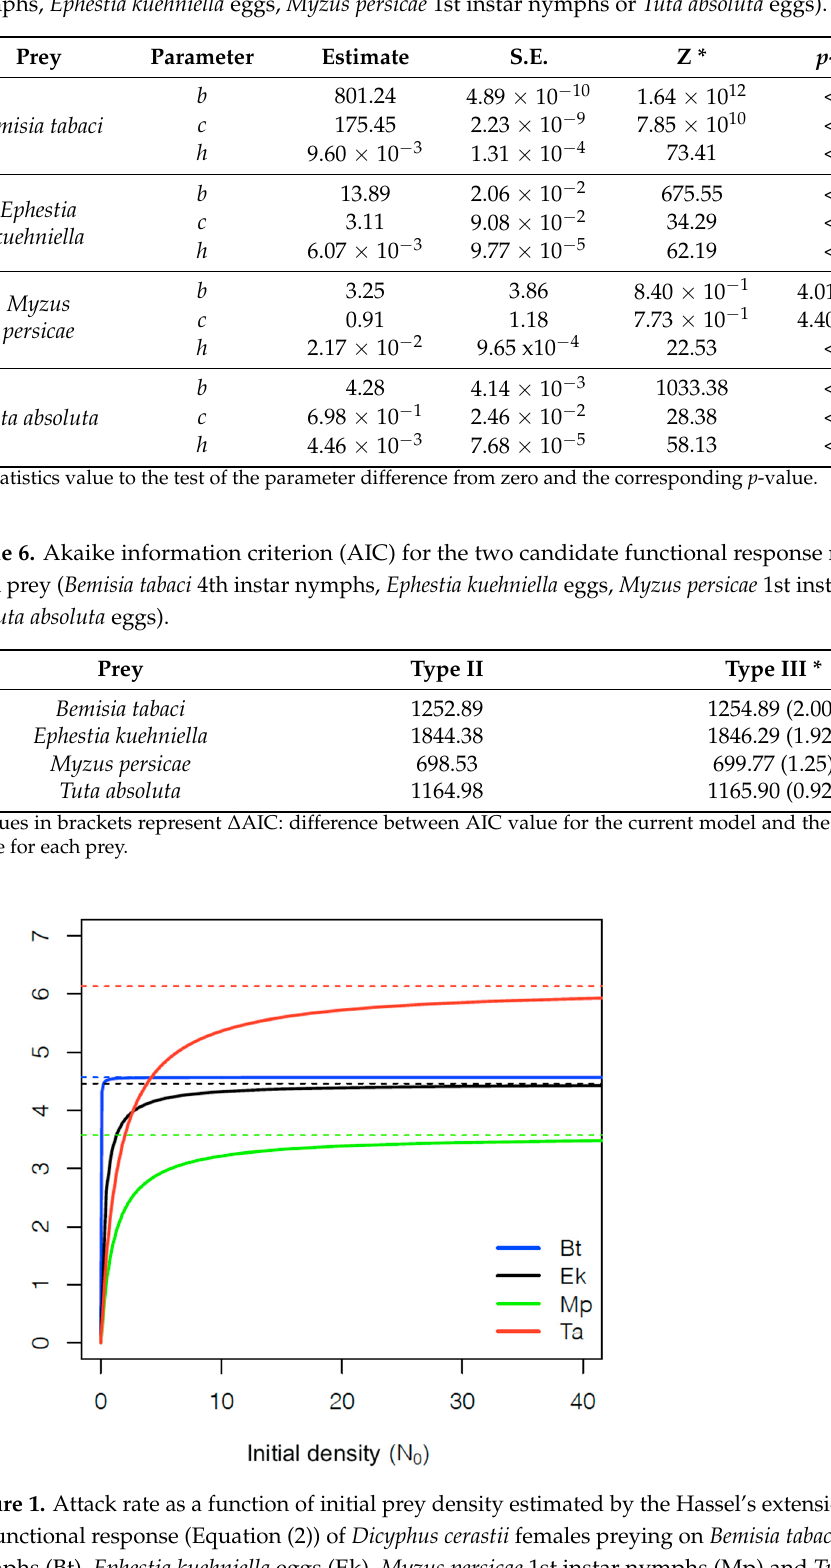
Figure 2. Functional response curves of Dicyphus cerastii females when preying on Bemisia tabaci 4th instar nymphs ( A ), Ephestia kuehniella eggs ( B ), Myzus persicae 1st instar nymphs ( C ) and Tuta absoluta eggs ( D ). Dots represent the average consumption and bars the respective standard error. Shaded areas represent bootstrapped 95% confidence intervals. Note that vertical and horizontal axis scales are not the same among prey species.